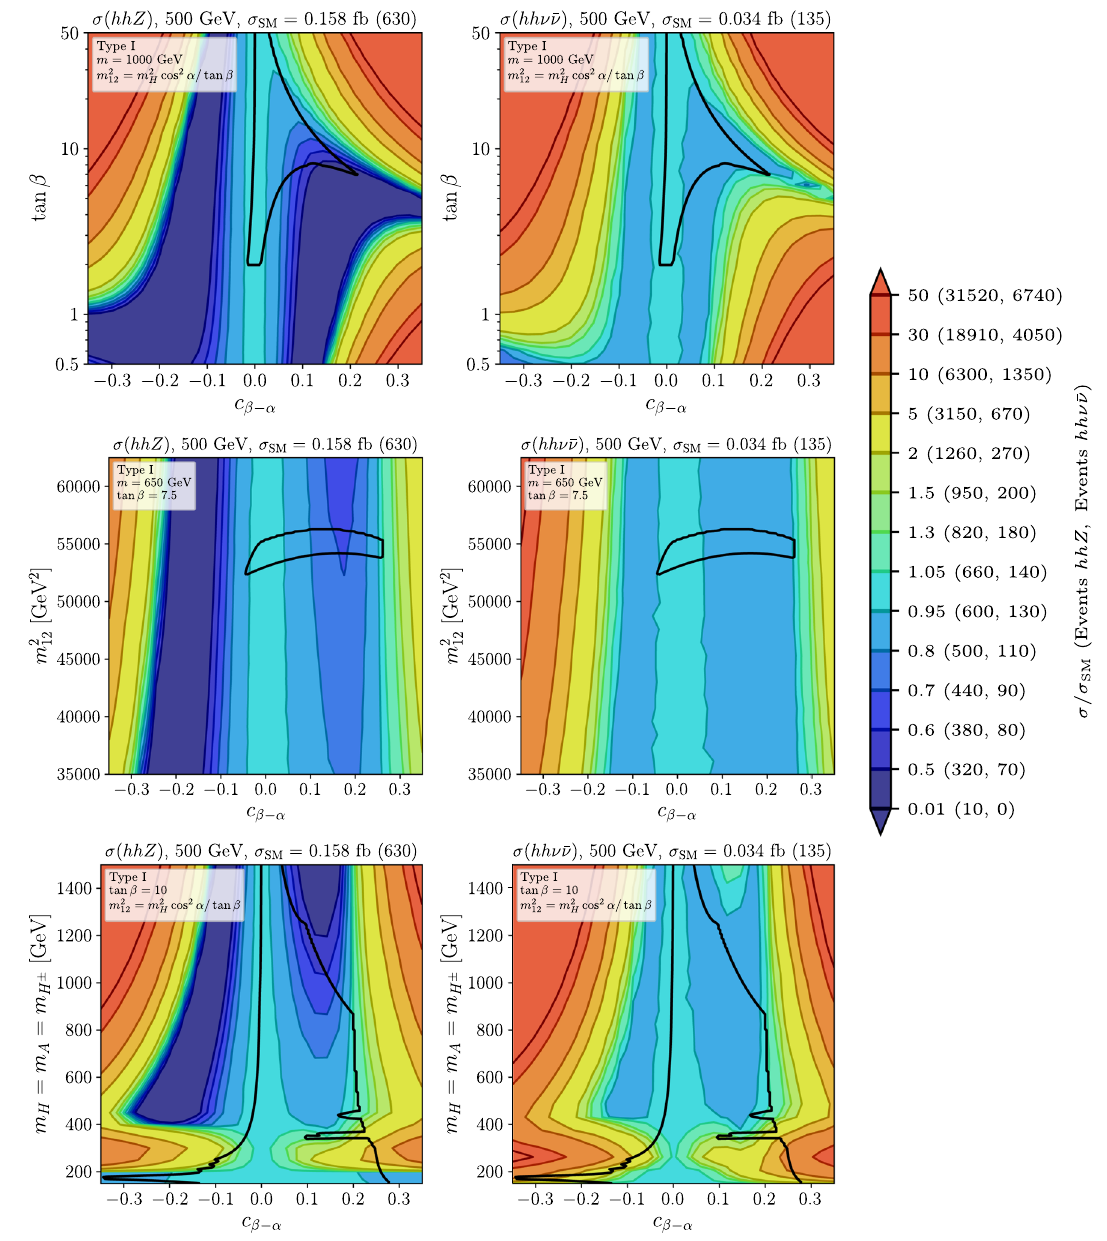
Fig. 4 Cross sections for e + e − → hhZ (left) and e + e − → hh ν ¯ ν √ s = 500 GeV for the benchmark planes 1-3 (top to bot- (right) for tom). The total allowed regions are those inside the solid black lines.